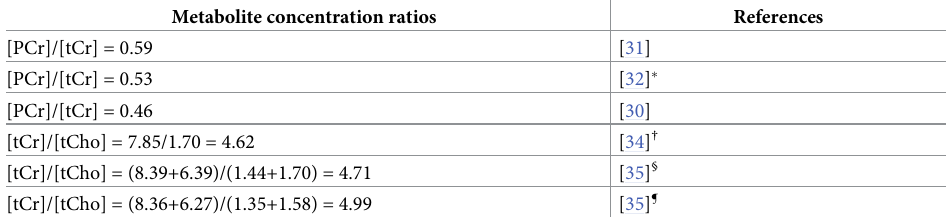
Table 4. Literature values used to calculate the expected cerebral [PCr]/[GPC+PC] ratio using Eq 2. Metabolite concentration ratios